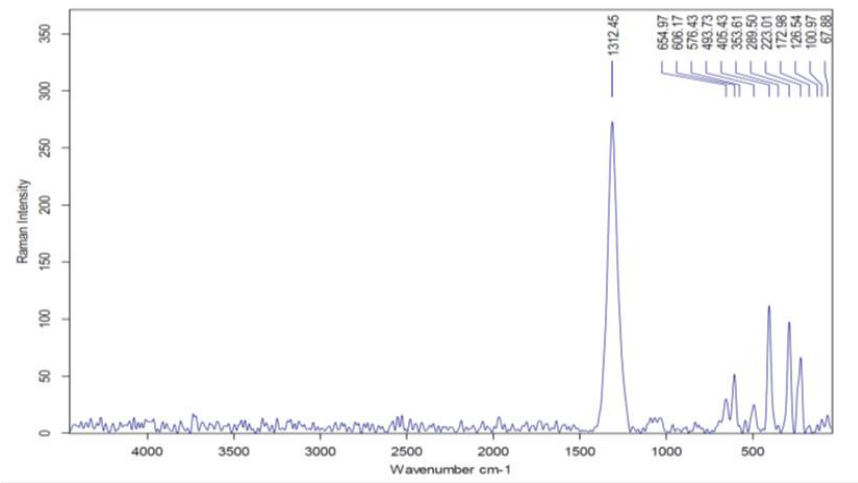
Figure 2. Raman spectra of LCF adsorbent.